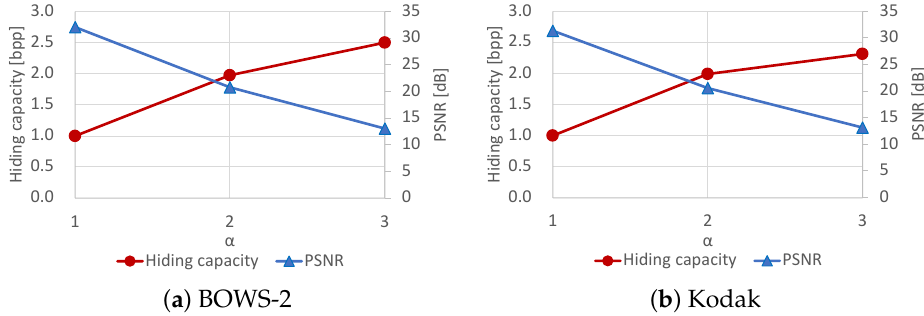
Figure 11. Trade-off between hiding capacity and marked-image